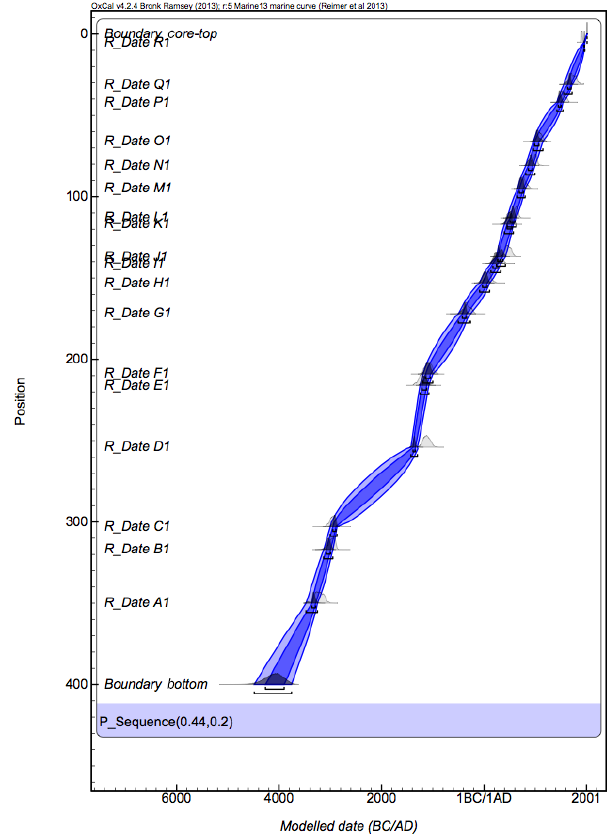
Figure 6. Evolution of the abundance in mollusc population (num- ber of individuals in 100cm 3 ) with depth: lagoonal species ( Hydro- bia acuta ), typical marine species ( Conus ventricosus : Conidae), marine influence ( Bittium reticulatum and Pusillina lineolata: Ris- soa).